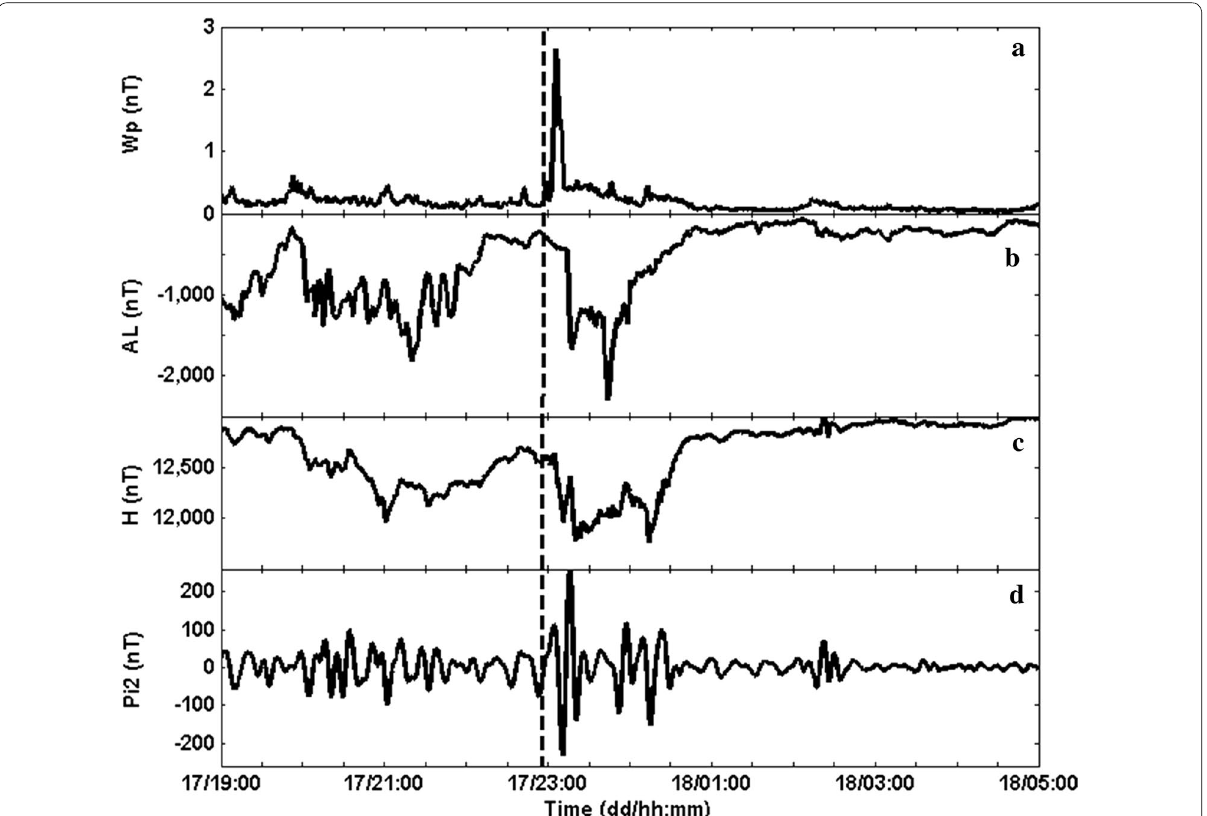
Fig. 5 Ground signatures of magnetospheric substorm associated with Pi2 pulsations, observed at the station OUJ during 19:00—05:00 UT on 17–18 March 2015. From top to bottom: a Wp index, b AL index, c H-component of magnetic disturbances observed at the station OUJ and d associated Pi2 event (filtered in the ULF band of 6.5–25 mHz) at OUJ. The onset of Pi2 is marked with a vertical dashed line at 22:58 UT (01:44 MLT